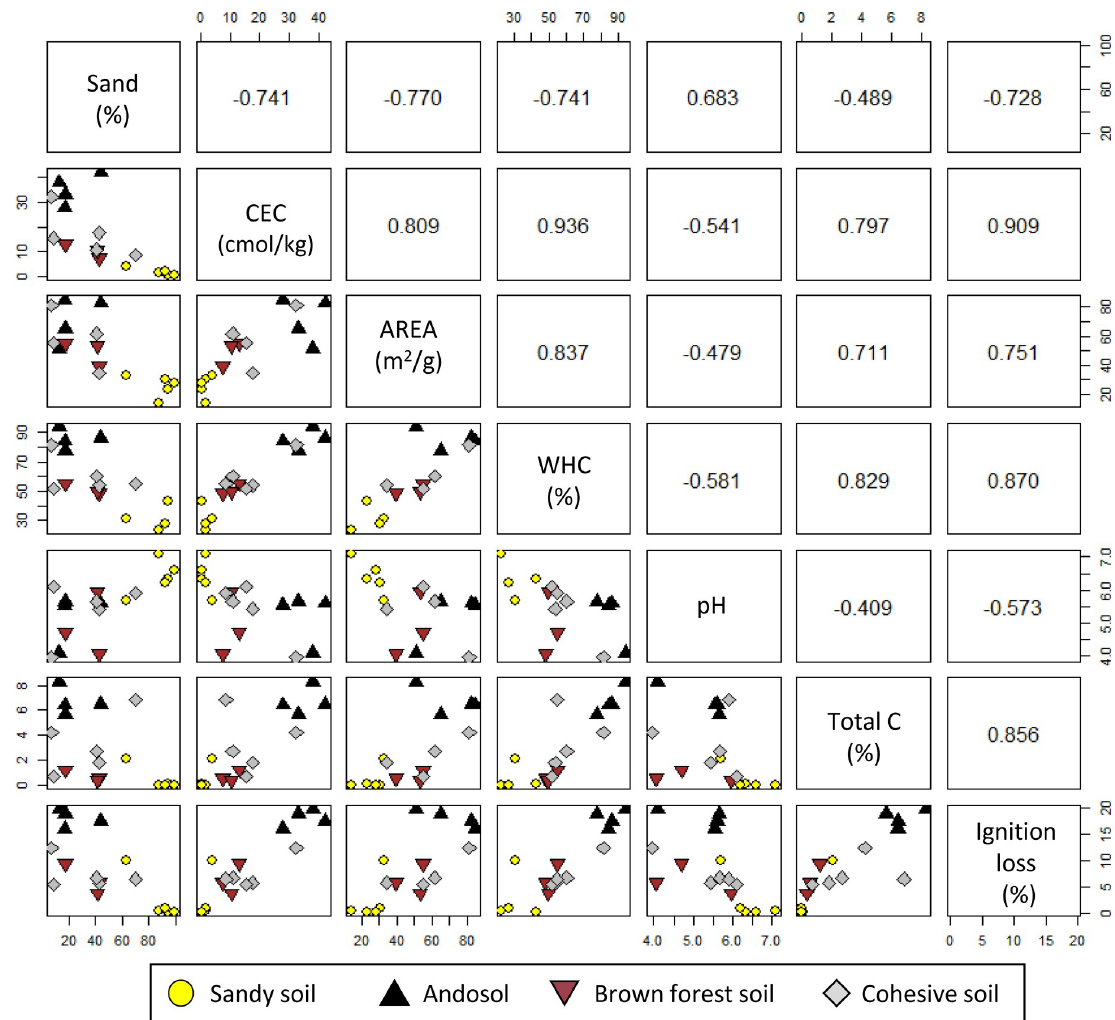
Fig 2. Correlation plots of physicochemical properties of 17 soil samples. Lower left, correlation plots; upper right, correlation coefficients. WHC, water-holding capacity.